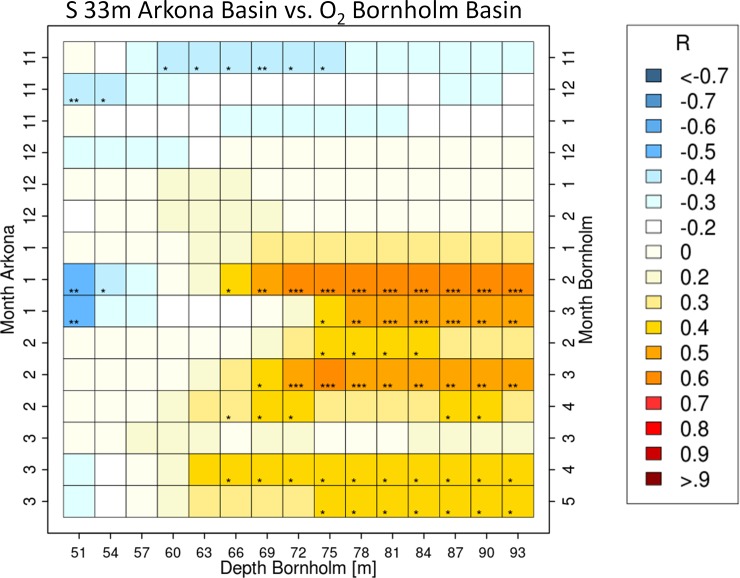
Correlation coefficients of salinity at 33m depth for different months in the Arkona Basin vs. oxygen concentration at various depths for successive months in the Bornholm Basin.Time series of monthly mean values for the correlations were taken from hydrodynamic model runs (BSIOM) hindcasting the period 1970–2015. From the entire period November to March salinity values at the 33m depth level in the Arkona Basin were correlated respectively to the vertical oxygen distribution in the Bornholm Basin between November and May. The value of the correlation coefficient is depicted in colour code for each combination of months selected for salinity and oxygen values and additionally the corresponding depth layer in the Bornholm Basin. The significance of each correlation is depicted with asterisks as follows: p>0.05 = no asterisk, p<0.05 = *, p<0.01 = **, p<0.001 = ***.